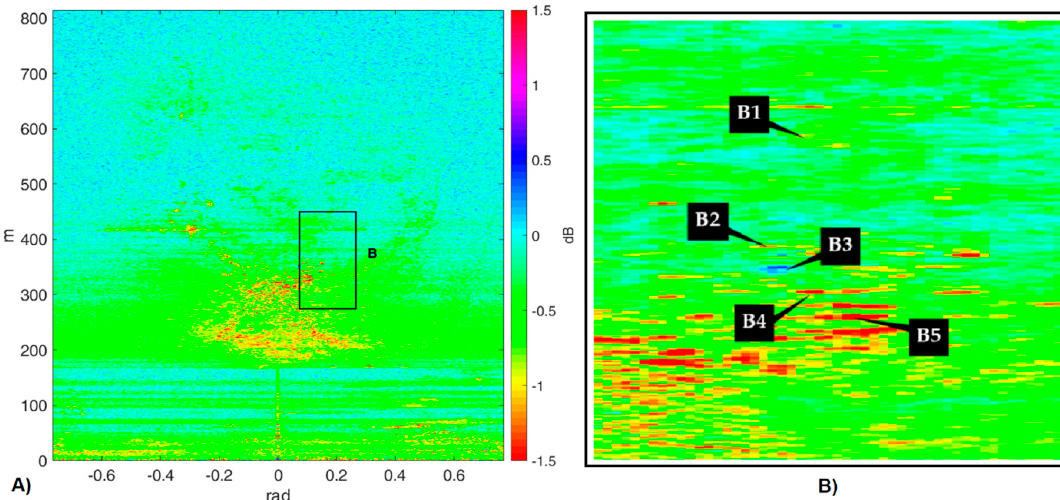
Figure 20. ( A ) Ratio of the RR/RL amplitude. ( B ) Zoomed area of the B area (included in the black Figure 20. (A) Ratio of the RR/RL amplitude. (B Zoomed area of the B area (included in the black rectangle in Figure 20A). The positions of the scatters are labelled in black. rectangle in Figure 20A). The positions of the scatters are labelled in black.